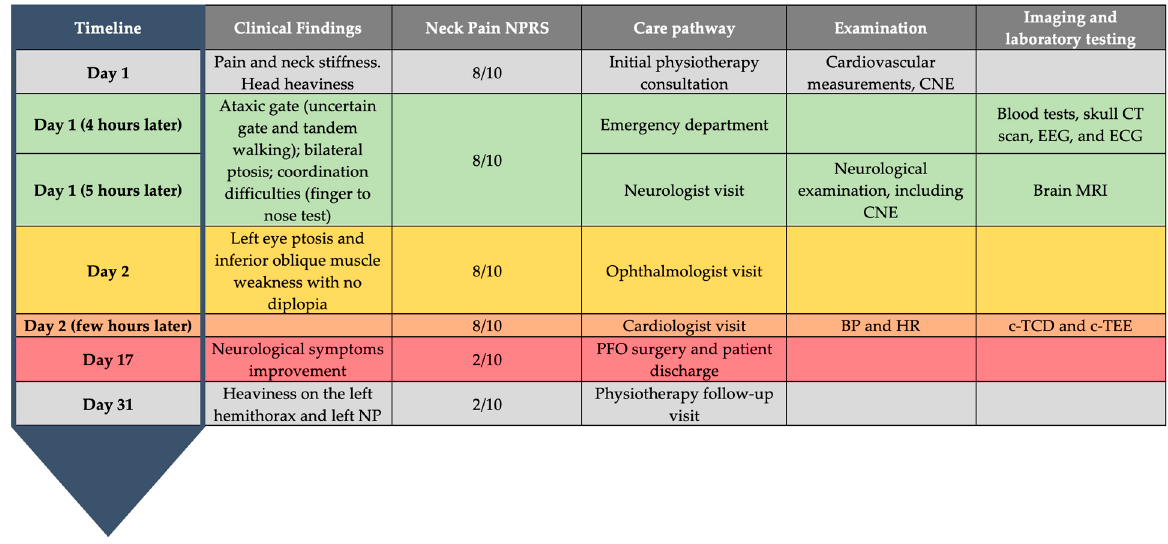
Figure 4. Timeline of the interventions, outcomes and follow-up. NP: neck pain; CNE: cranial nerve examination; CT: computerized tomography; MRI: magnetic resonance imaging; ECG: electrocardiography; BP: blood pressure; HR: heart rate; c-TCD: contrast transcranial doppler; c-TEE: contrast transesophageal echocardiogram; EEG: electroencephalogram; PFO: patent foramen ovale.